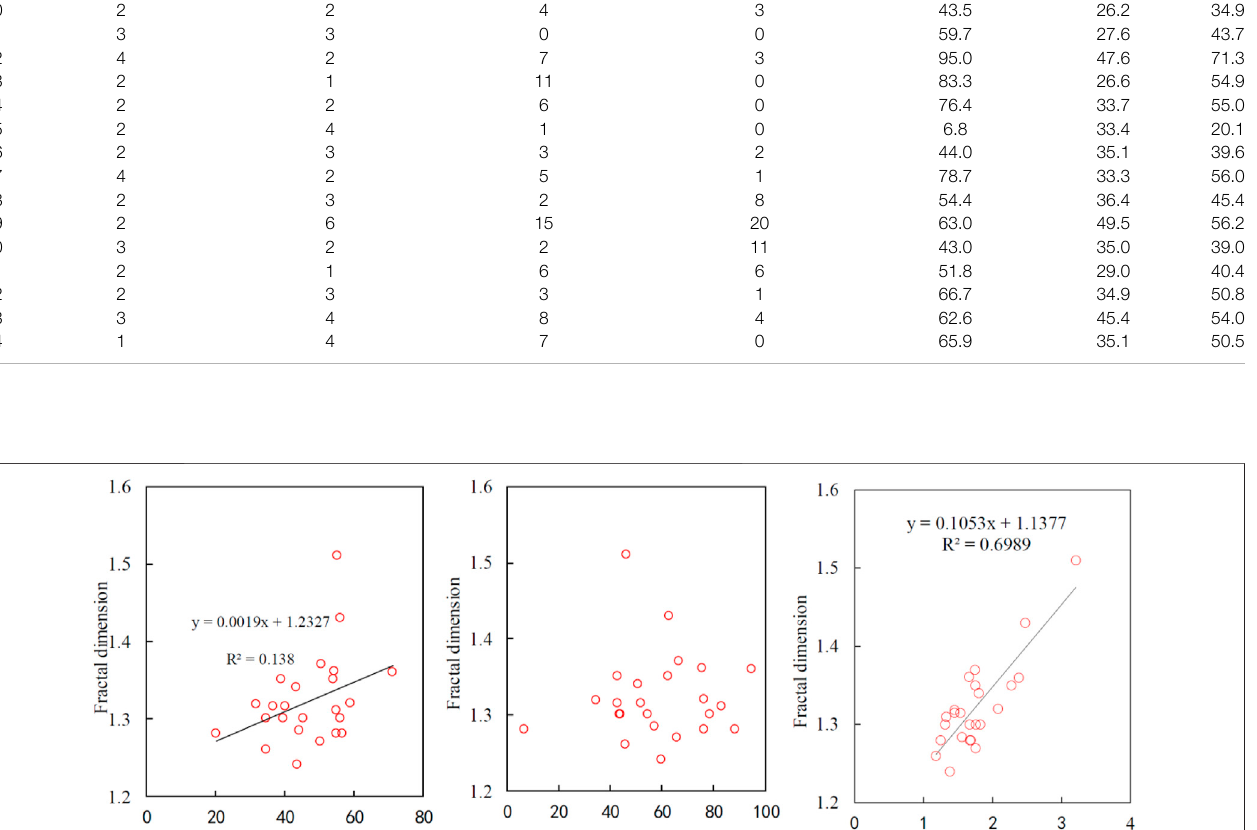
Frontiers in Earth Science |